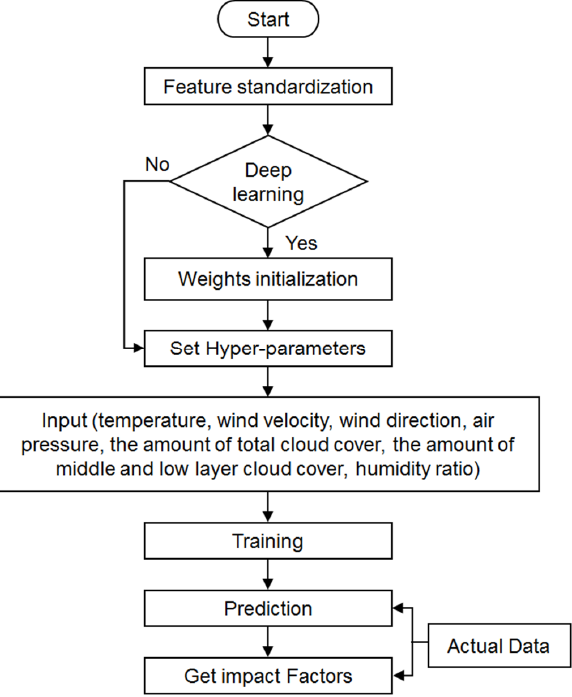
Figure 6. Training process for artificial neural network.